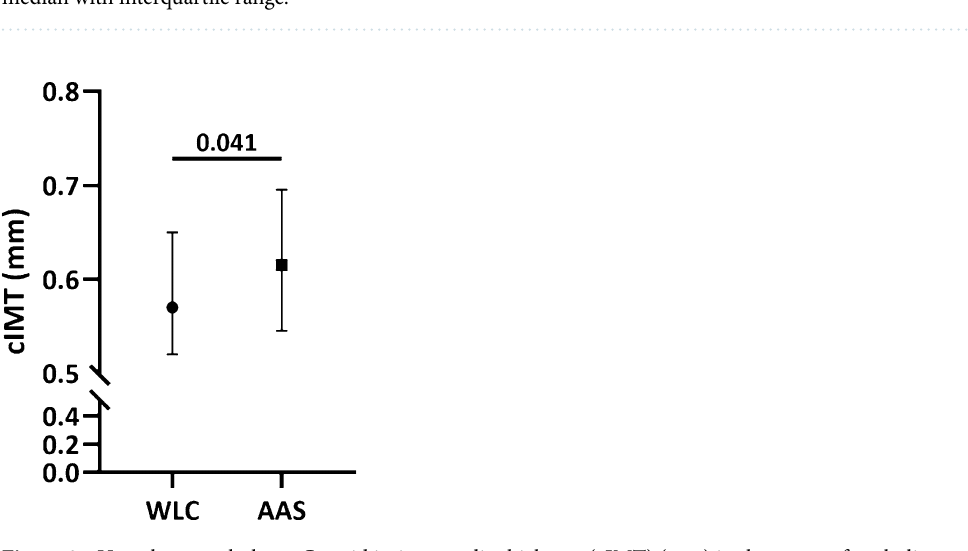
Figure 1. Vascular function: ( A ) Pulse wave velocity (PWV) in anabolic androgenic steroids (AAS) users (N = 56) and weight lifting controls (WLC) (N = 67). Data presented as median with interquartile range. ( B ) Carotid artery compliance in AAS users (N = 56), compared to WLC (N = 58). Percentage increase calculated from the difference in inner diameter (mm) of the left carotid artery within one heart cycle. Data presented as median with interquartile range.